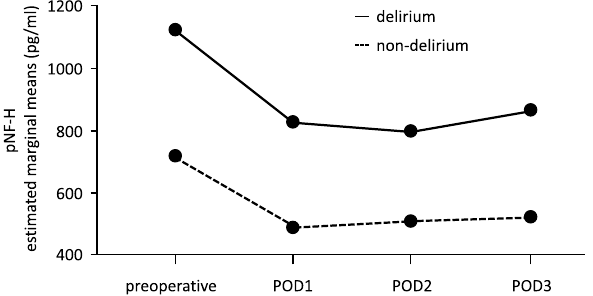
Figure 1. Changes in the serum levels of pNF-H in patients with (solid line) and without (dotted line) delirium. The preoperative value of serum pNF-H originated from the same dataset published in Ref. 12 . The sample size at each point is indicated in online Supporting Information Table S2. POD, postoperative day; pNF-H, phosphorylated neurofilament heavy